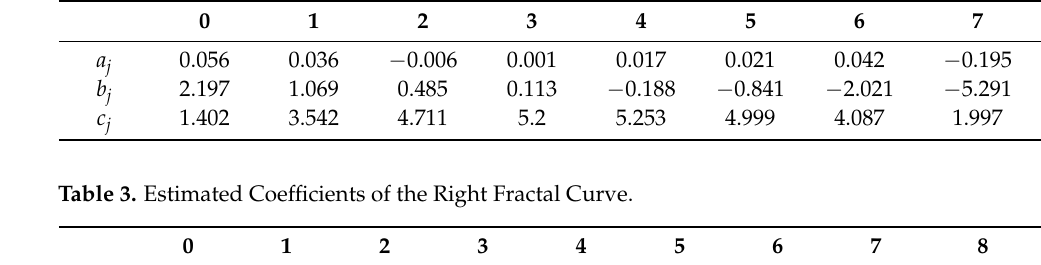
Figure 5. Enlarged polystyrene fiber ( left ) and estimated fractal curves ( right ).